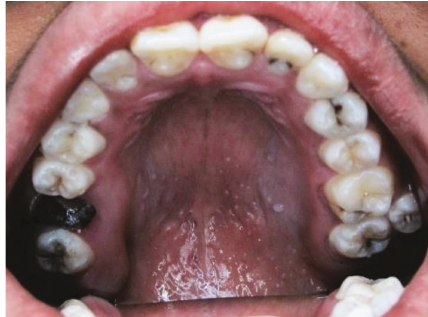
Figure 21: Case 4: supernumerary tooth (paramolar) associated with talon cusps (occlusal view).